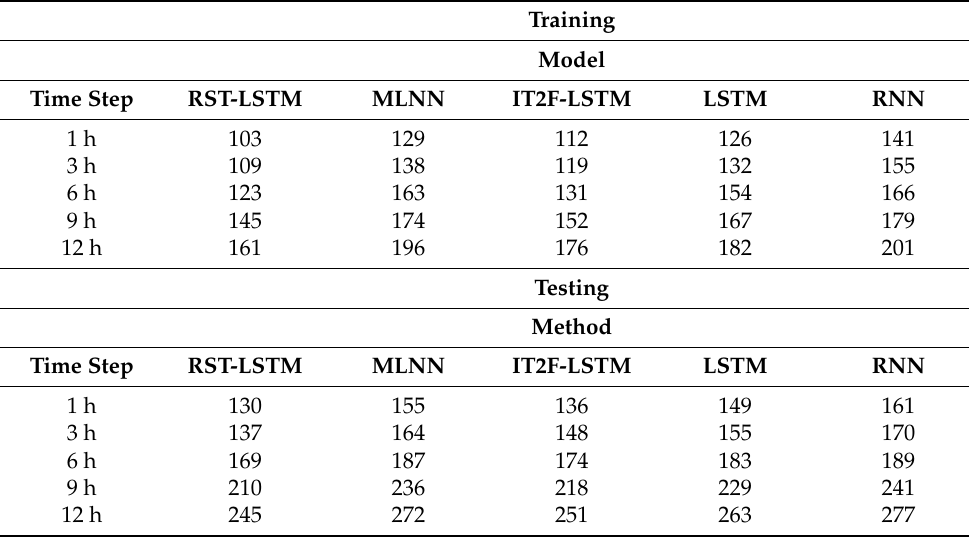
Table 1. SEE (sum of squares error) of training and testing datasets using forecasting approaches for different time steps.